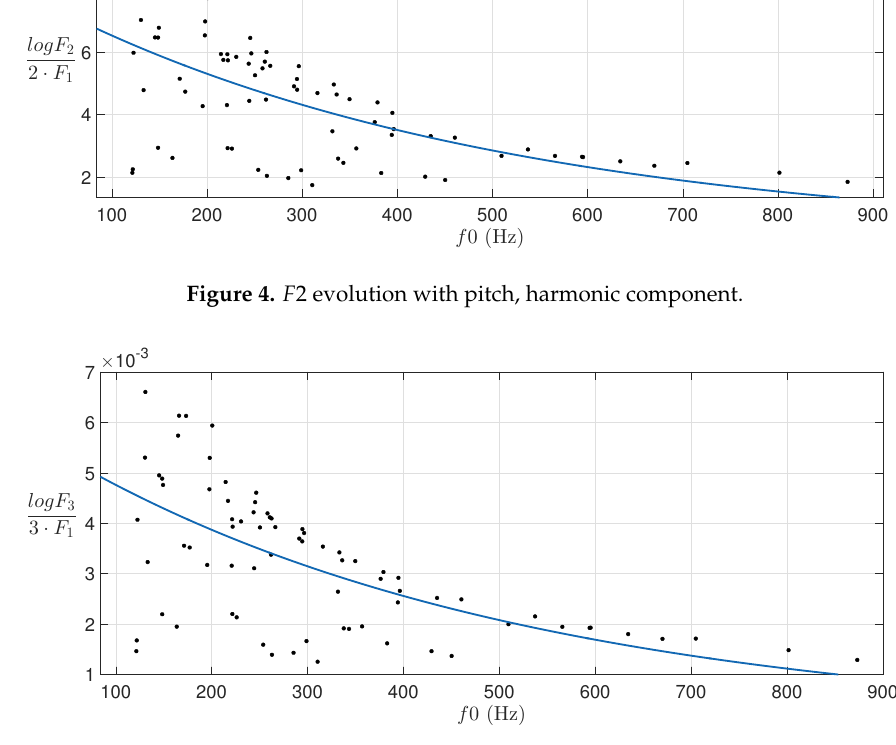
Figure 5. F 3 evolution with pitch, harmonic